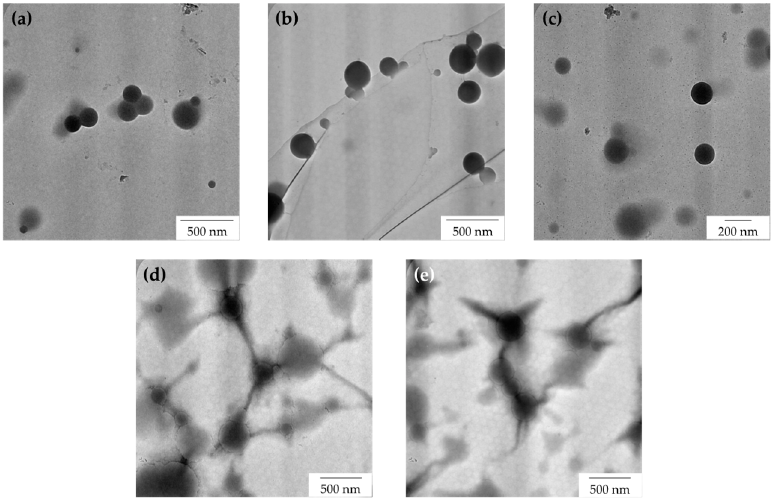
Figure 8. TEM images of AG-stabilized NRL with variable loadings of ( a ) 0.1 phr, ( b ) 0.2 phr, ( c ) 0.3 phr, ( d ) 0.4 phr, and ( e ) 0.5 phr after the freeze–thaw processes.